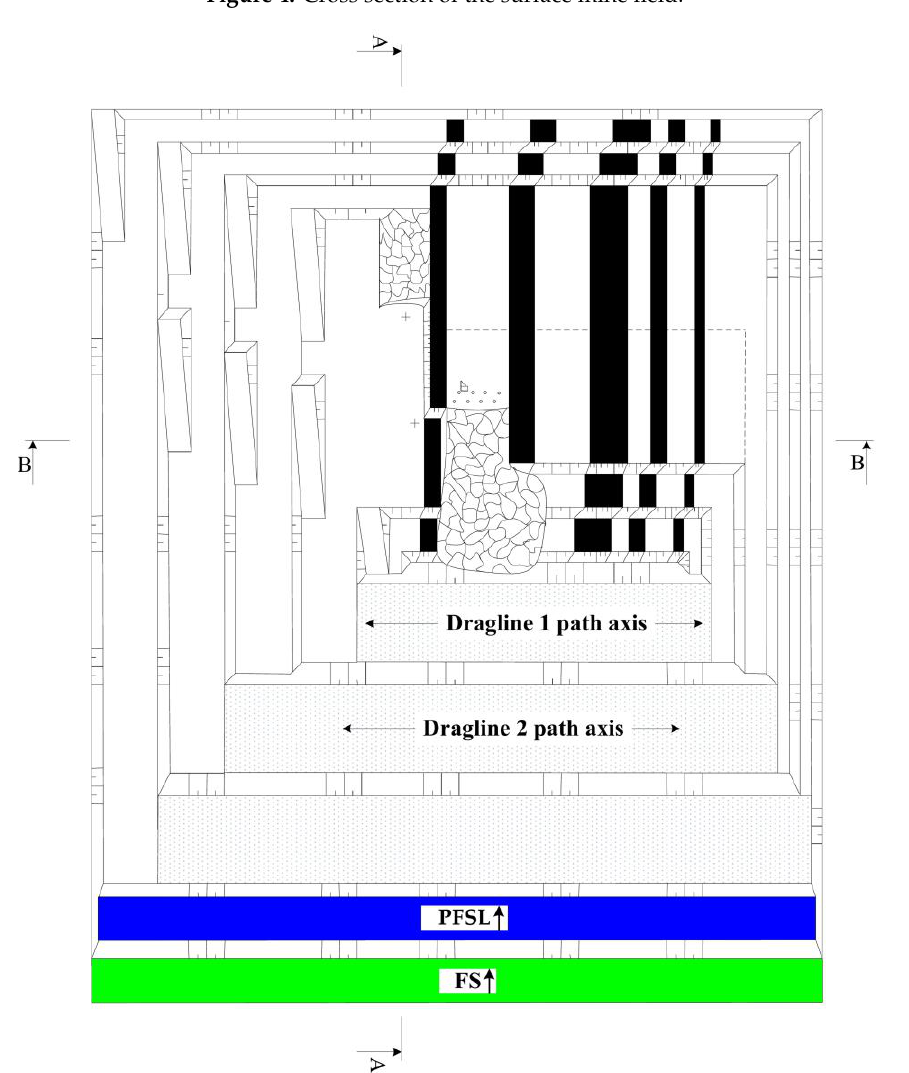
Figure 5. The scheme of a block-and-layer mining method with layered-areal combined transport and direct dumping technology (PFSL–potentially fertile layer; SL–soil layer).